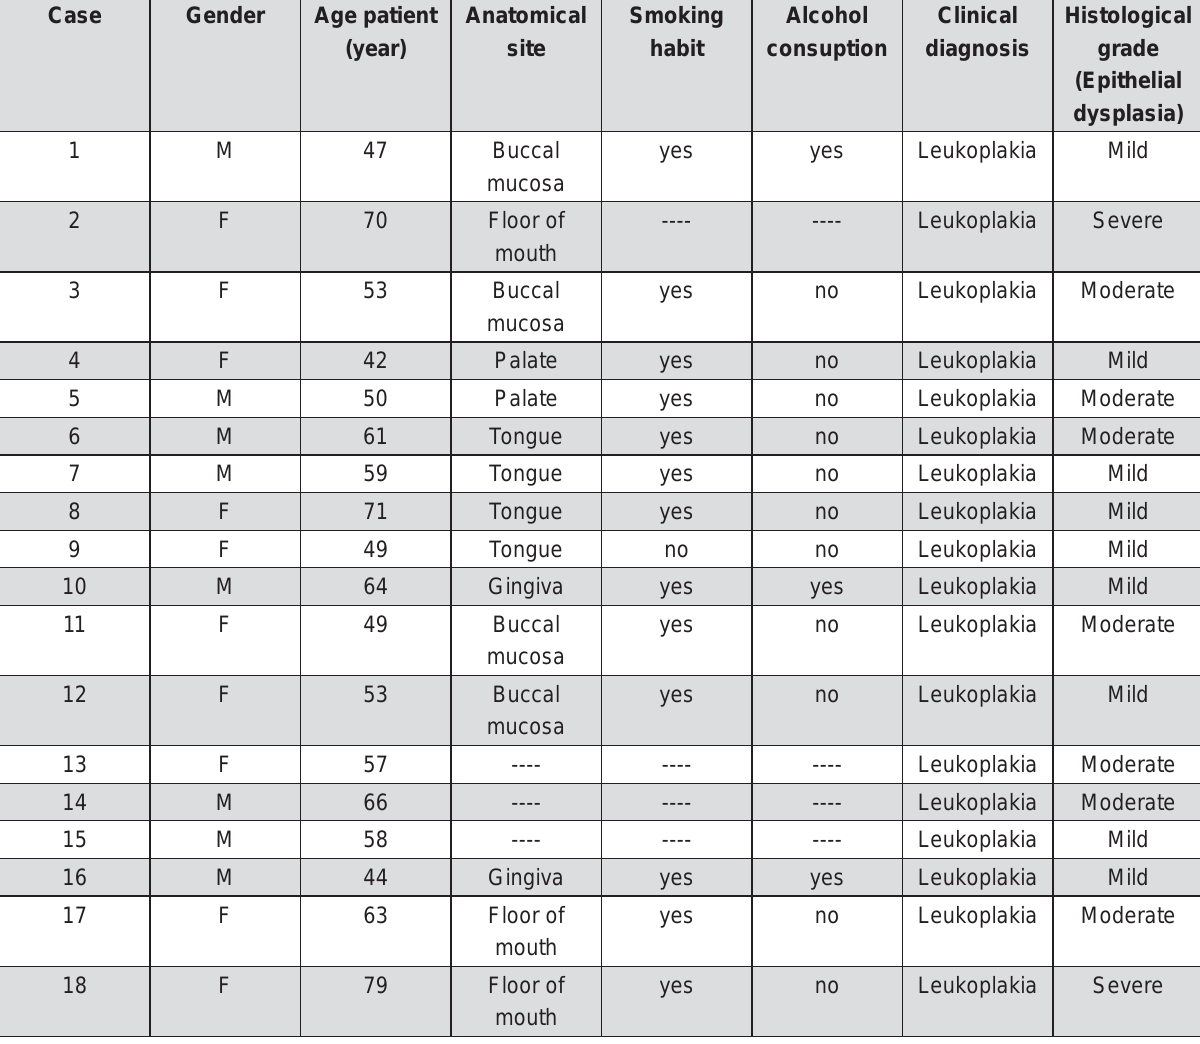
Figure 1- Clinical and pathological characteristics of the oral leukoplakia